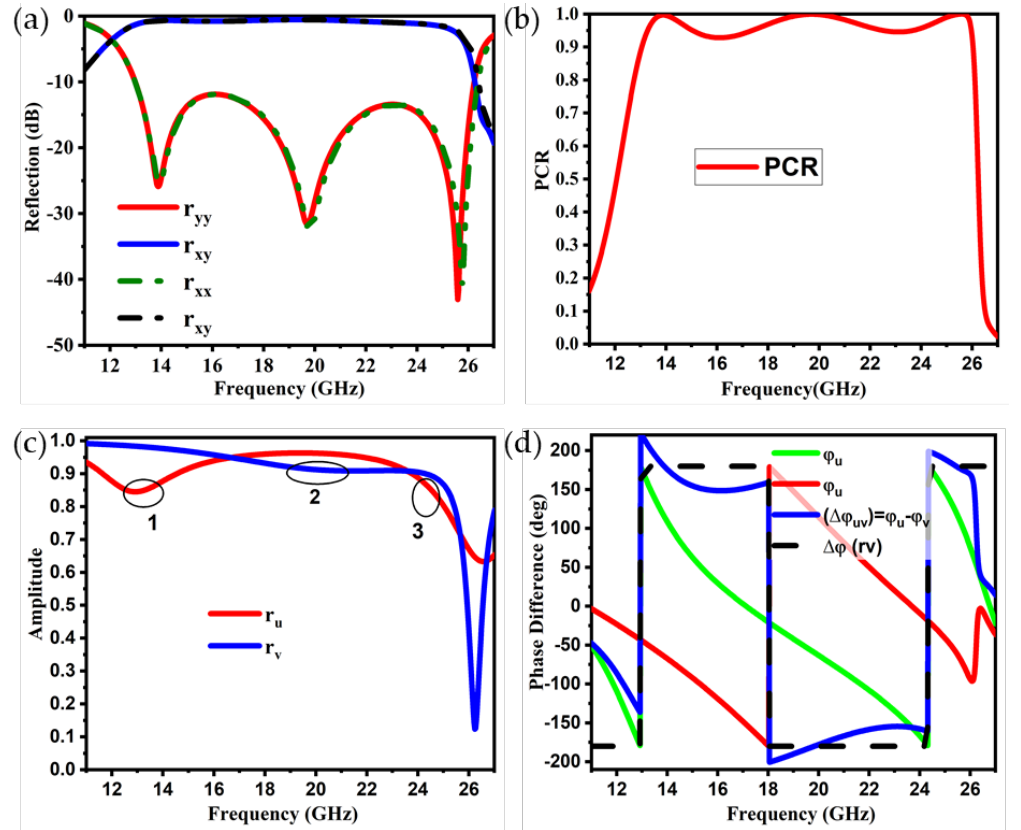
Figure 3. Polarization conversion response of proposed metasurface: ( a ) co − and cross − polarization component 𝑟 𝑦𝑦 and 𝑟 𝑥𝑦 , ( b ) polarization conversion ratio ( PCR ), ( c ) magnitude of orthogonal components 𝑟 𝑢 and 𝑟 𝑣 , and ( d ) phase difference.